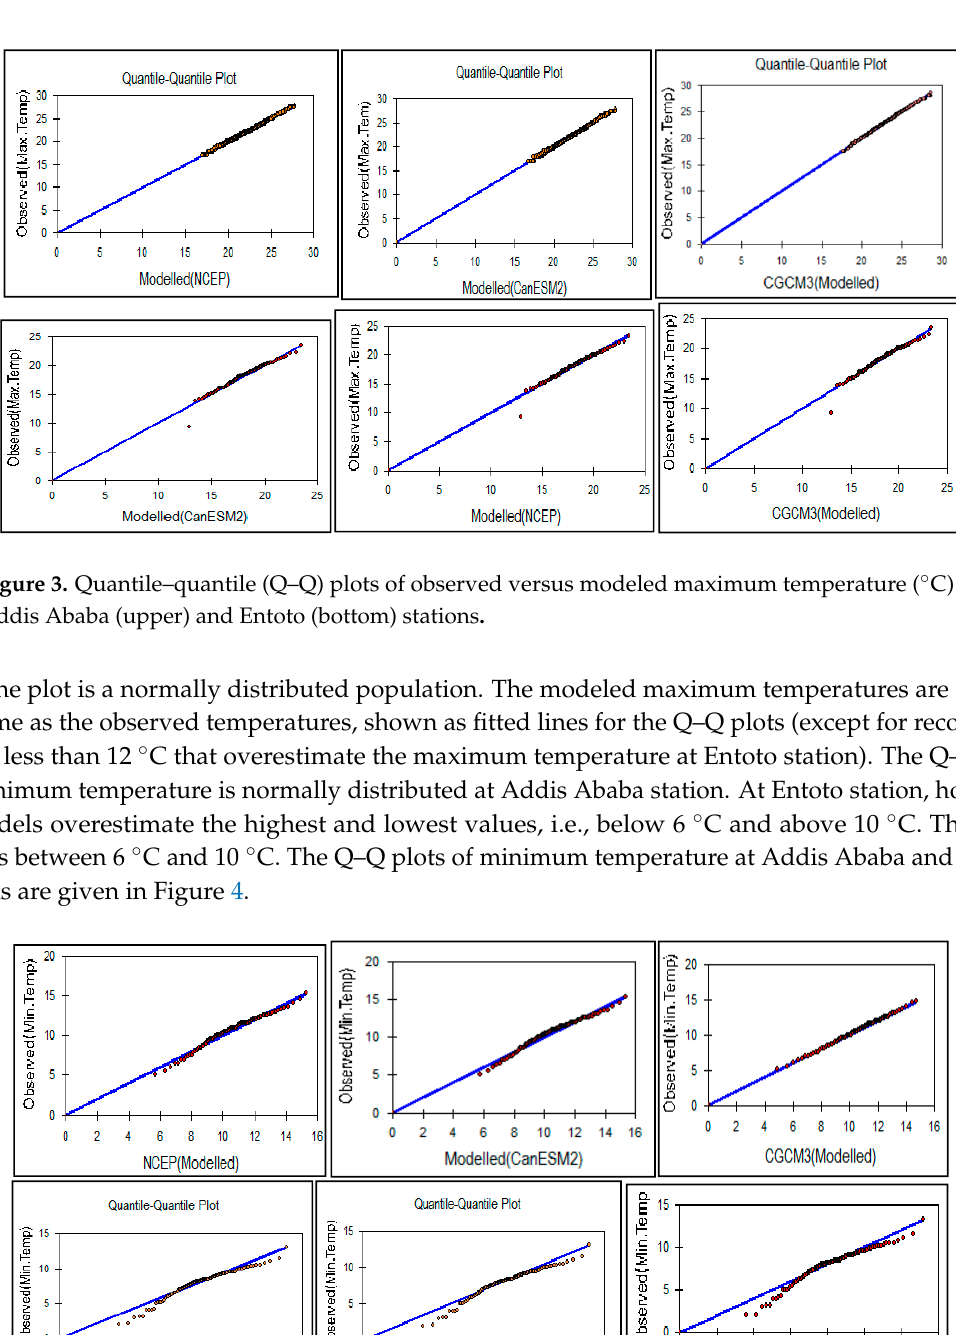
Figure 4. Quantile–quantile plots of observed versus modeled minimum temperature (°C) at Addis Ababa (upper) and Entoto (bottom) stations during the validation period.